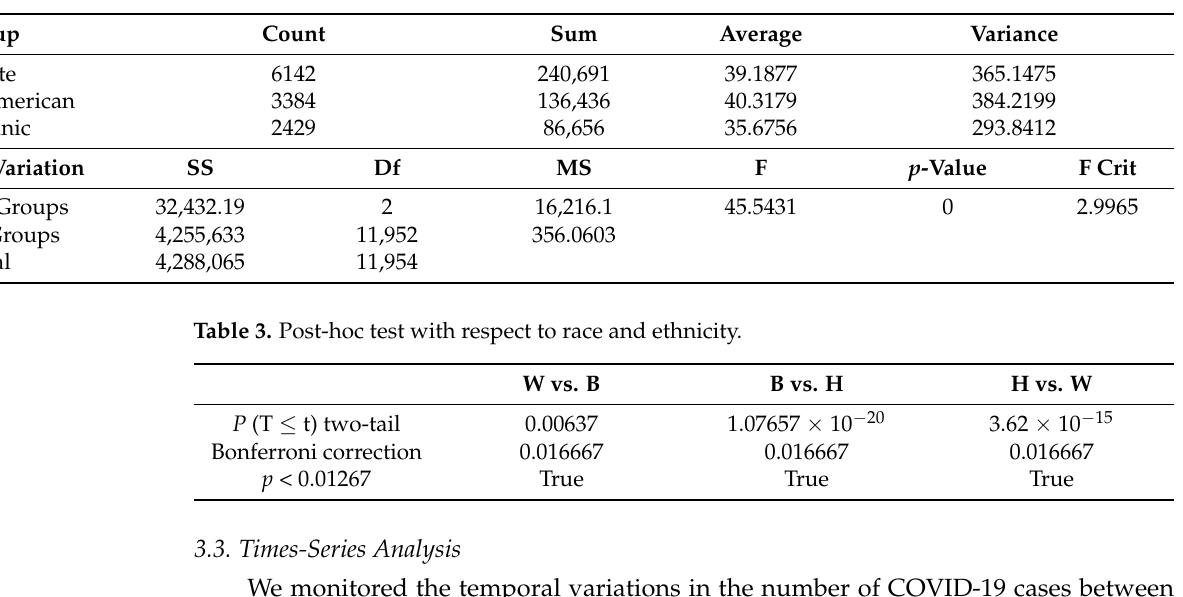
Table 2. One-way ANOVA to test differences with respect to race and ethnicity.